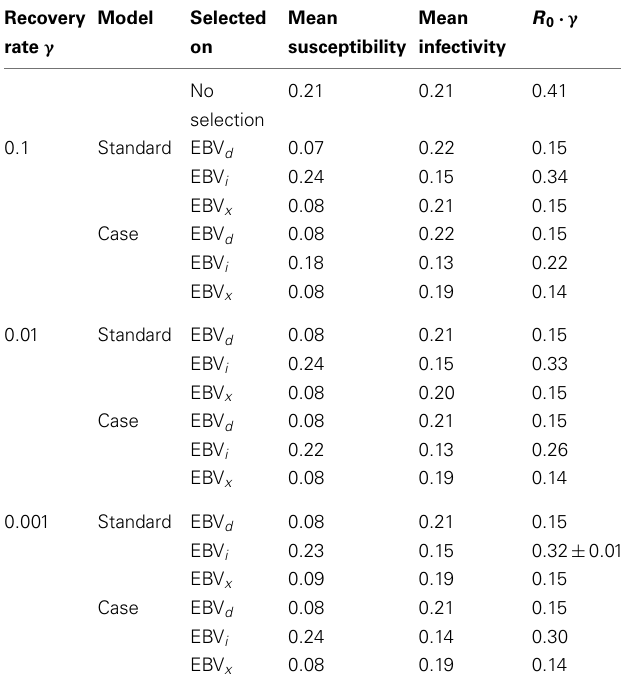
Table 2 | Selection impact on true susceptibility, infectivity, and risk and severity of an